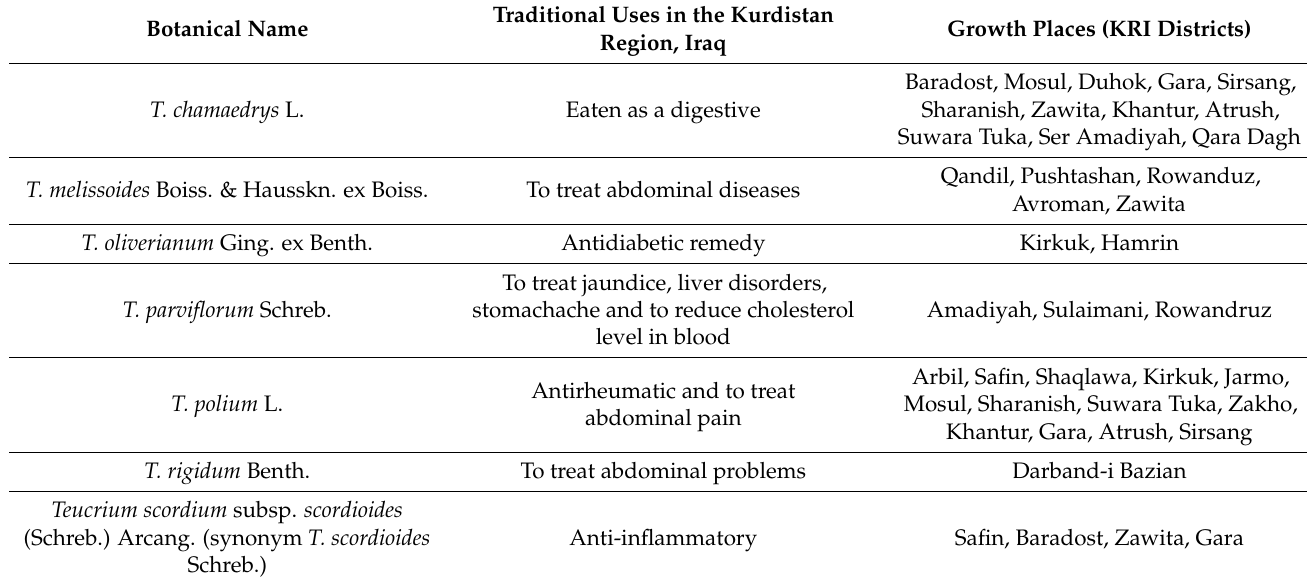
Table 1. Teucrium taxa used in the traditional medicine of the Kurdistan Region,